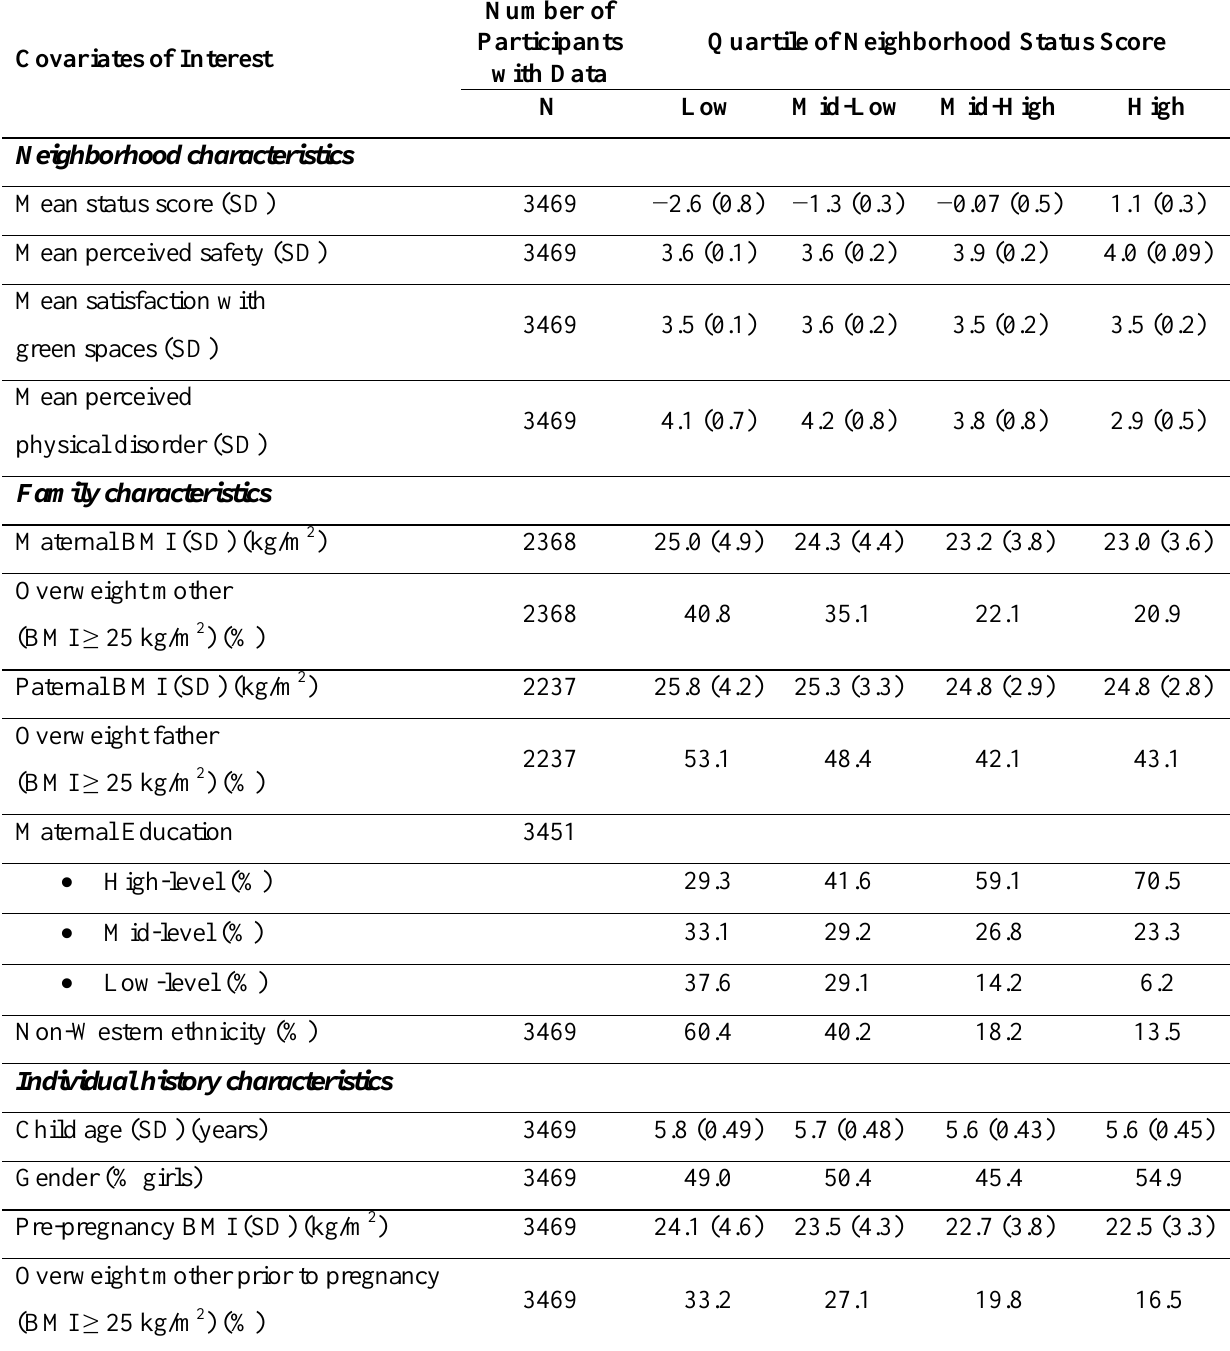
Table 1. Demographics and child outcomes per quartile of neighborhood socioeconomic status